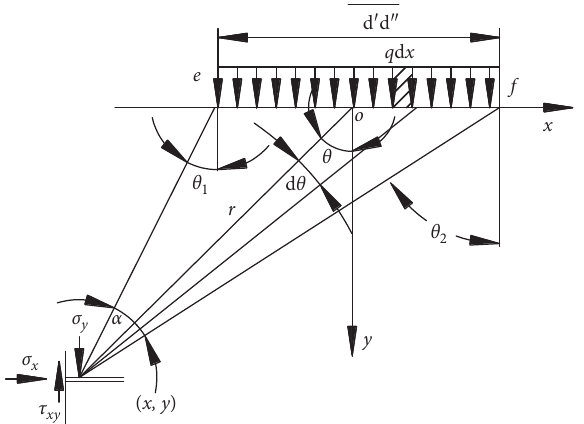
Figure 11: Diagram of a point on the floor subjected to the load d ′ d ″ .